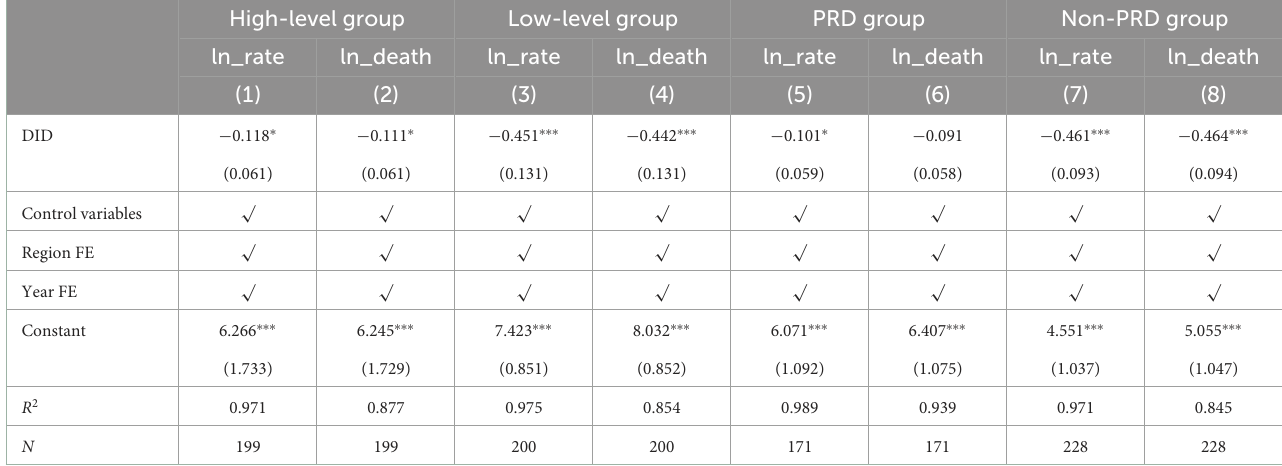
TABLE 7 Results of heterogeneity